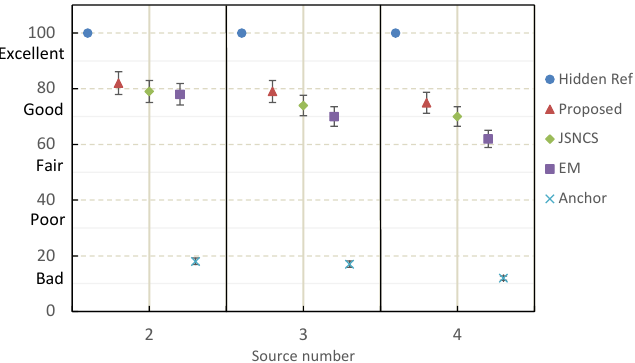
Figure 14. MUSHRA test results under the reverberant case with 95% confidence intervals.